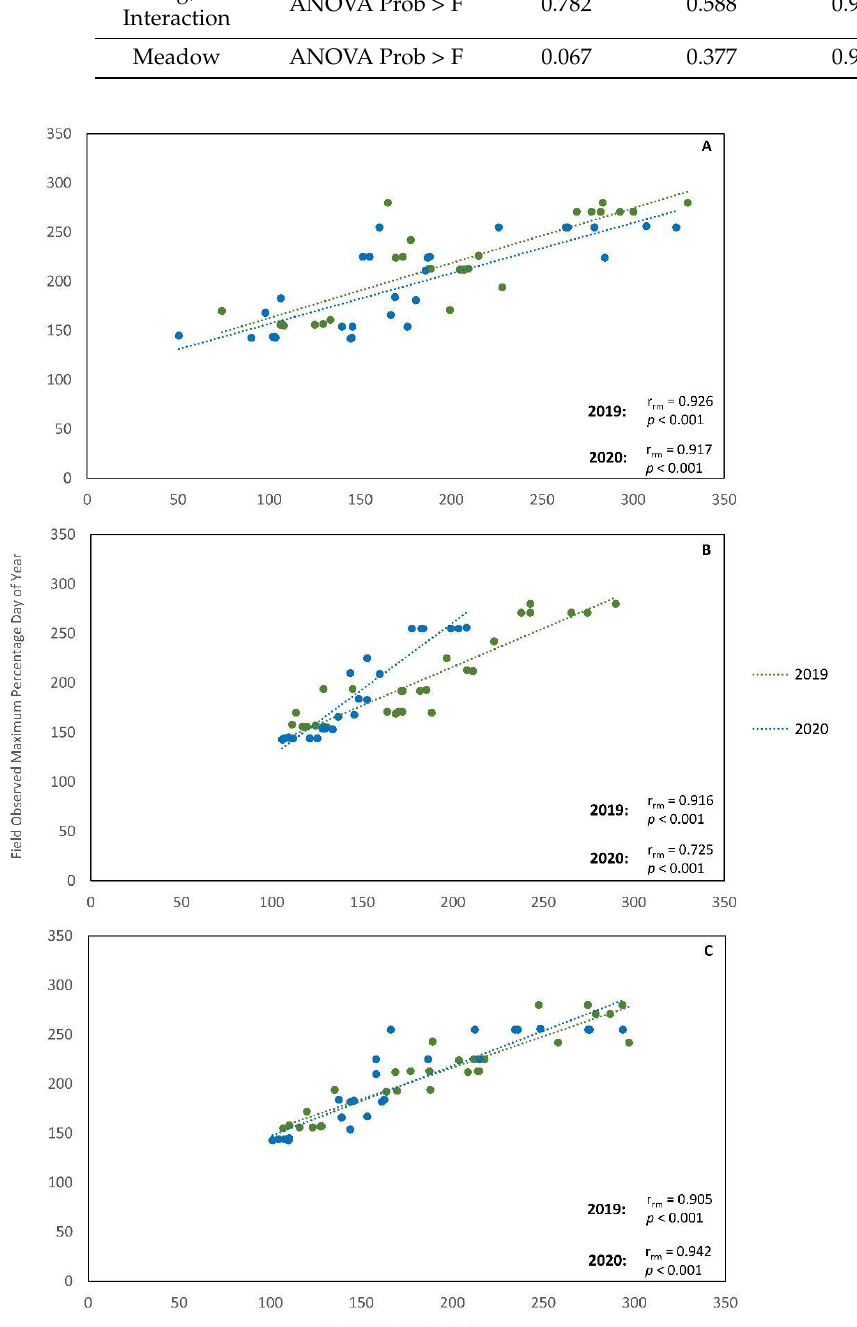
Figure 7. Plotted average day of year (DOY) for maximum percentage of observance for each phenology stage and camera-derived phenophase for ( a ) dry vegetative communities, ( b ) mesic vegetative communities, and ( c ) wet vegetative communities. Repeated measures correlation coefficients (r rm ) and p -values were calculated for each year and community type. Grazing intensity, as shown in the ANOVA model, had little effect on phenophase date (Figure 8). For the UD, SD, and DD phases, the treatment that had the latest average date varied across community type. For example, for the UD phase in 2020, the grazed